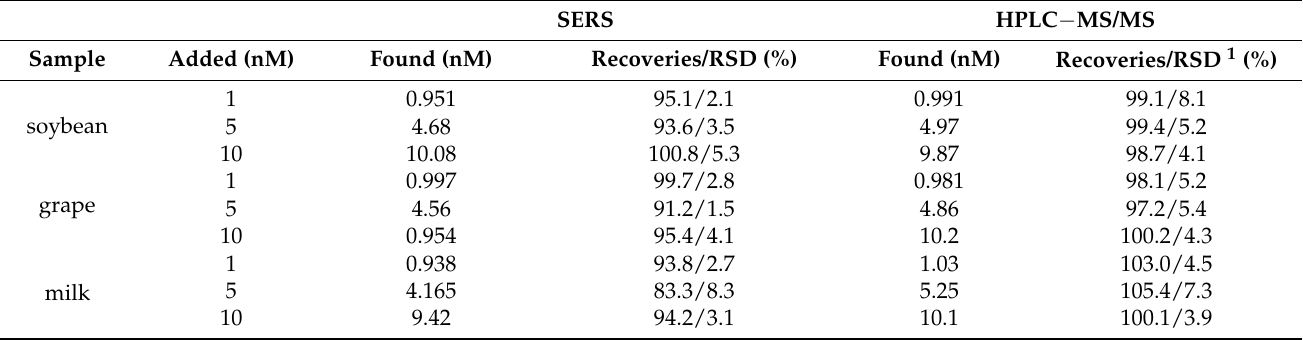
Table 1. Results of OTA Residues Detection in Real Samples by Aptasensor.